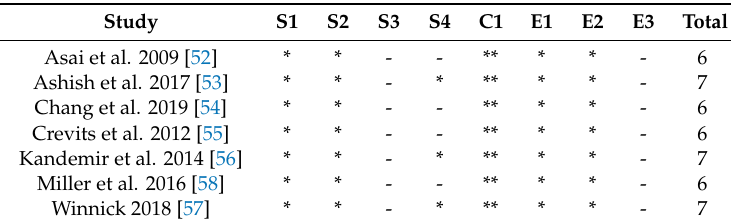
Abbreviations: Rep = Repetition.